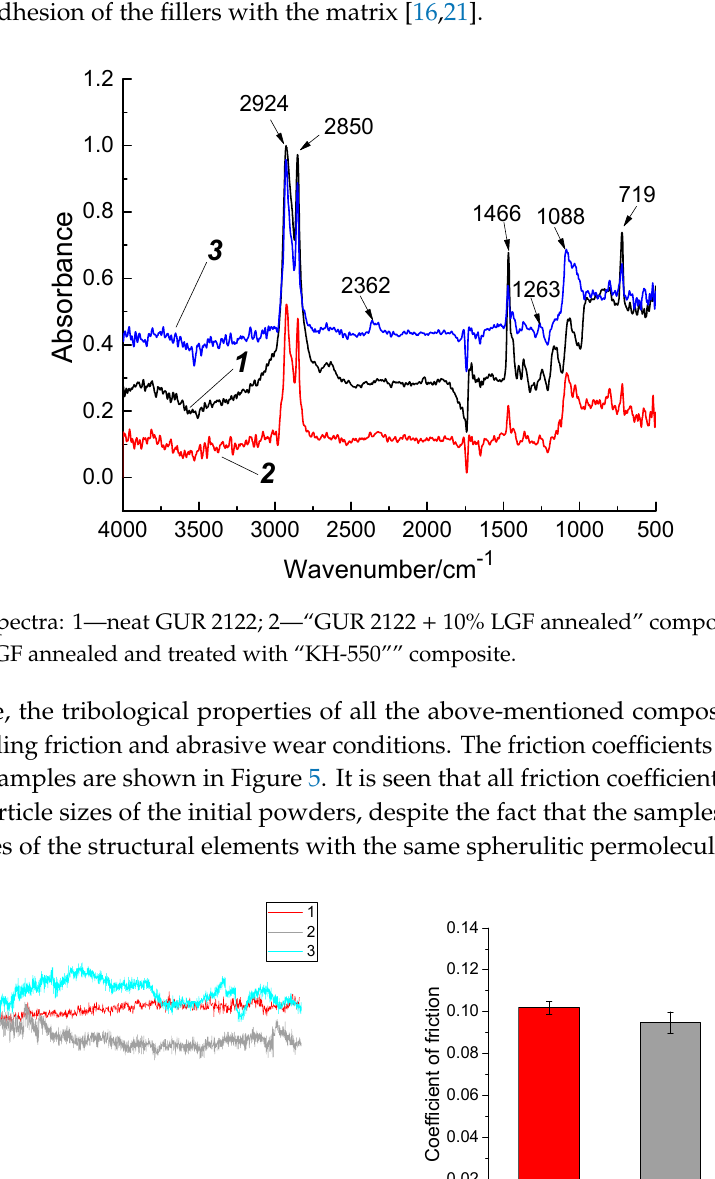
( b ) Figure 6. Diagrams on wear rates at dry sliding friction ( a ) and abrasive wear ( b ): 1—neat GUR 2122; 2—neat GUR 4120; 3—neat GUR 4022-6.